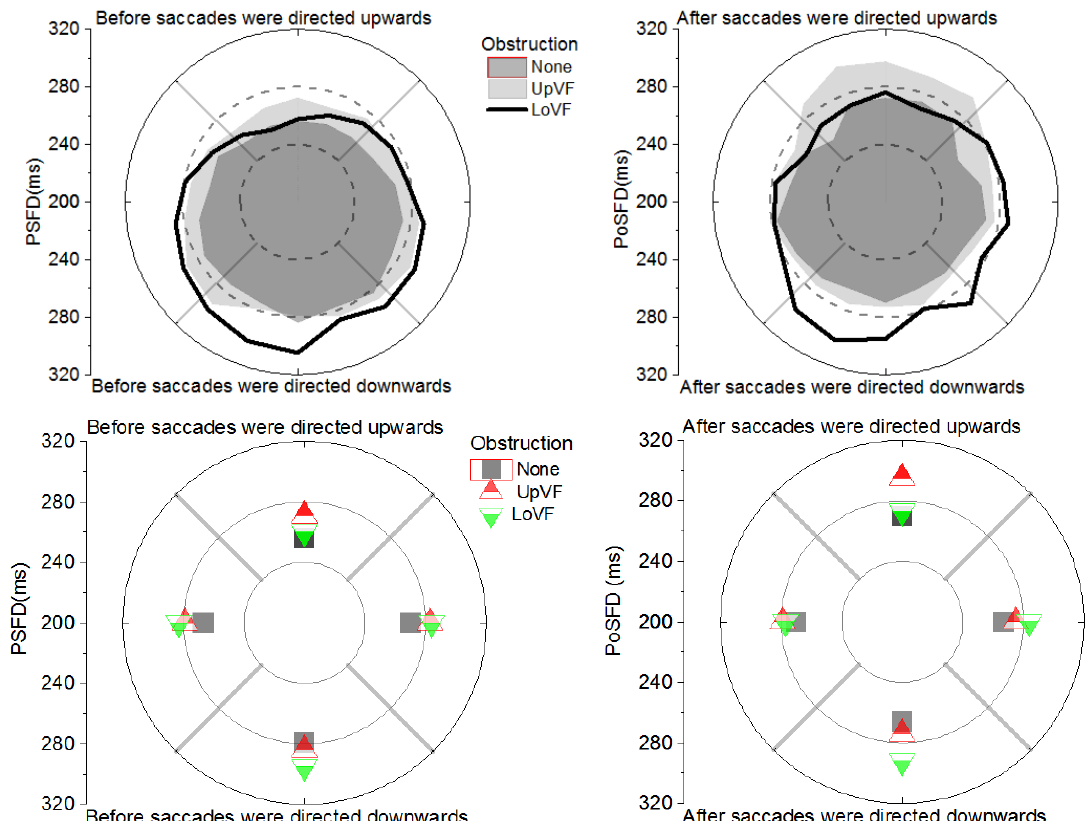
Figure 4 : (Left) Pre-Saccadic Fixation Durations and (Right) Post-Saccadic Fixation Durations as a function of saccade direction and obstruction condition. The panels on top depict fixation durations as a function of 20 deg saccade direction bins. The panels at the bottom depict fixation durations as a function of 90 deg saccade direction bins (i.e., Up, Down, Left, Right). All analyses in the text reflect a 3 Obstruction (None, Upper Visual Field Obstruction, and Lower Visual Field Obstruction) X 4 Saccade Direction (Up, Down, Left, Right) design